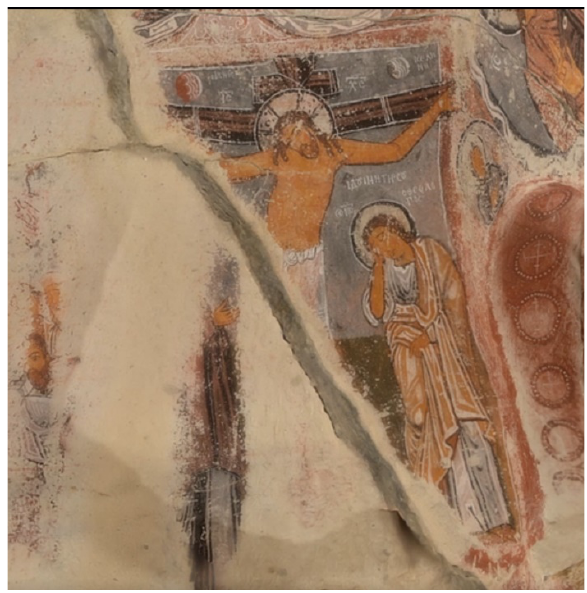
Figure 6. The Crucifixion of Merymana Kilisesi (current image)